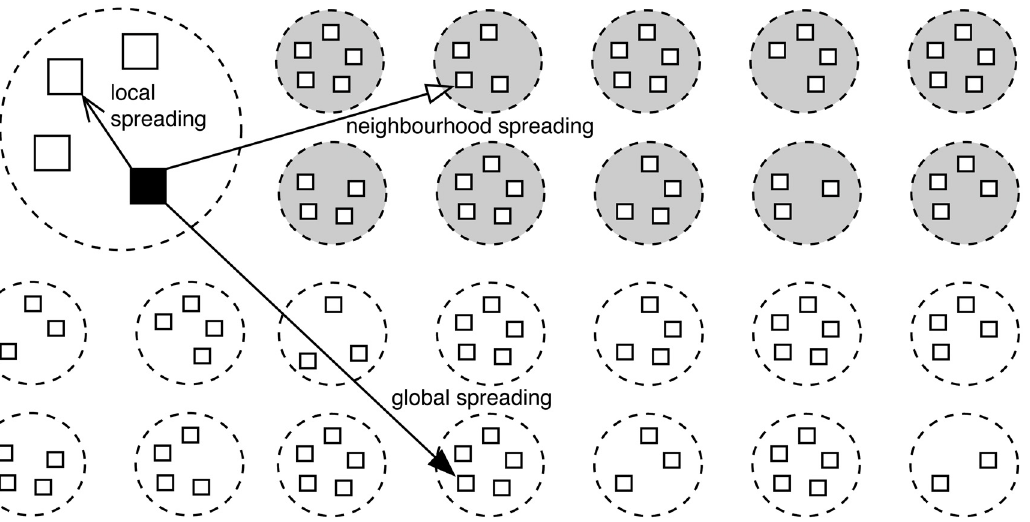
Fig 2. Conficker ’ s three probing strategies. (1) global spreading, where it probes any computer on the Internet at random; (2) local spreading, where it probes computers in the same local network; (3) neighbourhood spreading, where it probes computers in ten neighbouring local